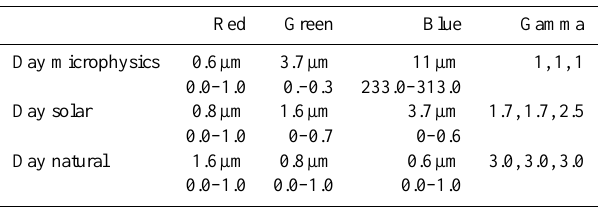
Fig. 14. Same as Fig. 5, but for the contrasting conditions between the polluted clouds over Manila (line 1) and the pristine background clouds (lines 2 and 3), as shown for VIIRS in Fig. 13. The MODIS image is not shown. Note the less noisy and smoother T – r e relations for VIIRS as compared to MODIS. Table 1. RGB compositions of microphysics, solar, and “natural color”